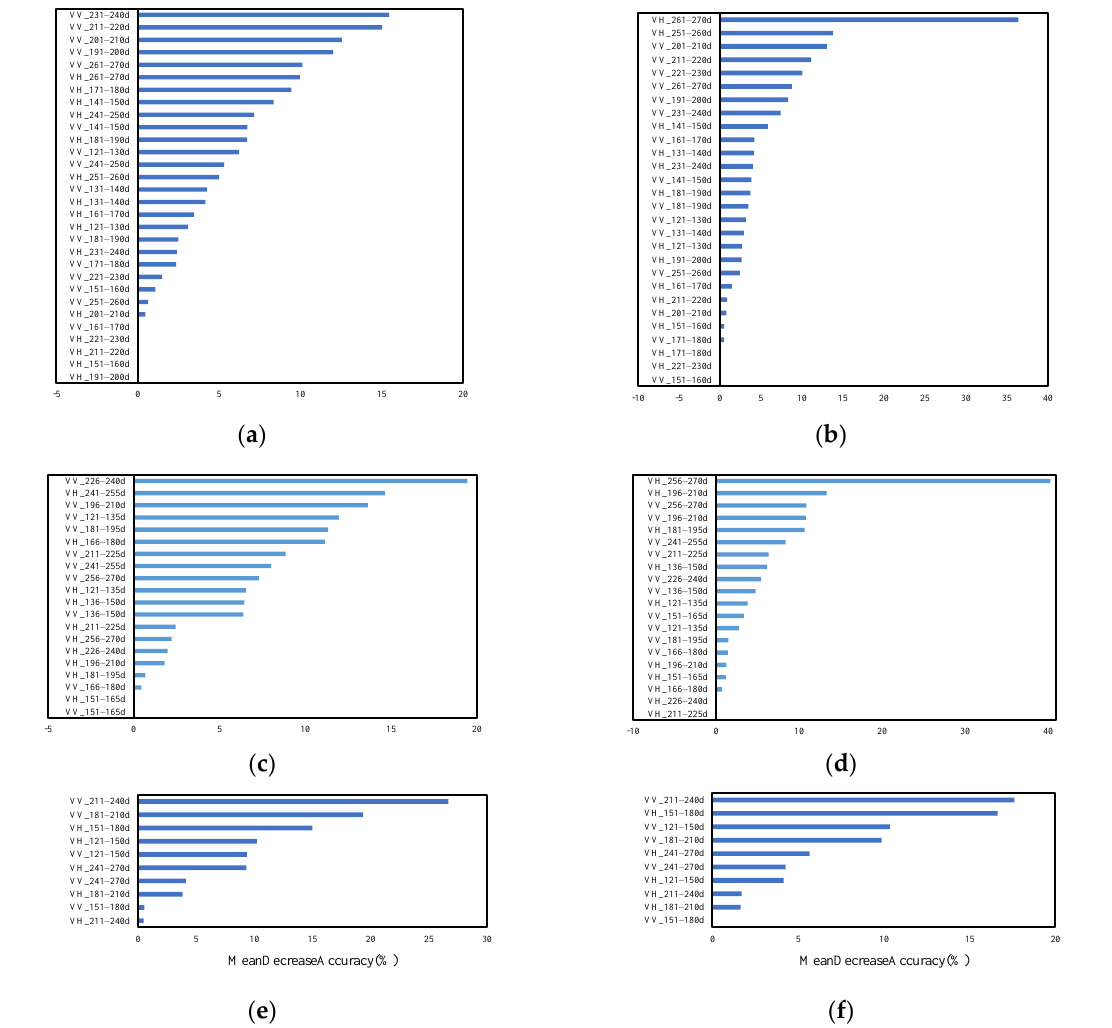
Figure 11. Importance assessment of crop classification features in 2018 and 2019 of Tongnan town with different time interval composite images (( a ) MeanDecreaseAccuracy_2018_10d; ( b ) MeanDecreaseAccuracy_2019_10d; ( c ) MeanDecreaseAccuracy_2018_15d; ( d ) MeanDecreaseAccuracy_2019_15d; ( e ) MeanDecreaseAccuracy_2018_30d; ( f ) MeanDecreaseAccuracy_2019_30d).